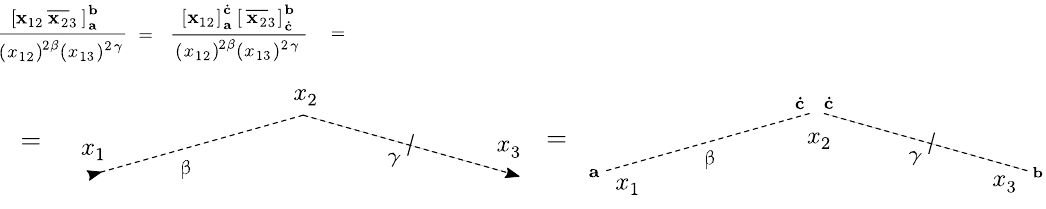
Figure 3 . Graphic representation of the product of two propagators respect to their spinor struc- ture. The arrows denote the order of the matrices [ x ] and [ x ] in the product.